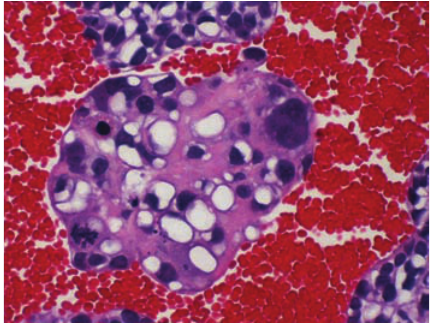
Figure 2: H & E stained cell block